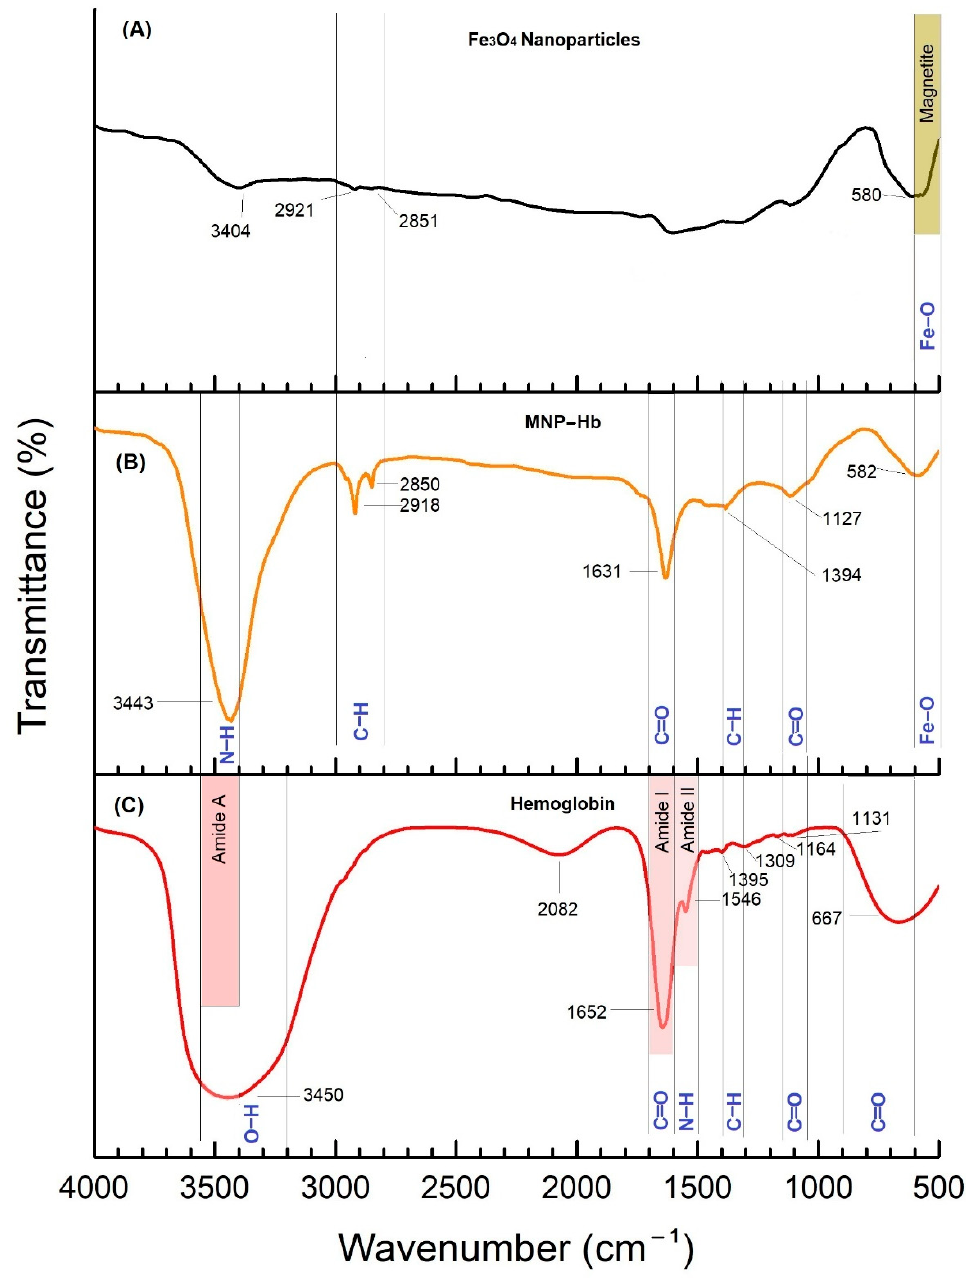
Figure 5. FTIR spectra of ( a ) bare magnetite nanoparticles, ( b ) hemoglobin and magnetite conjugates, ( c ) Hemoglobin. Note: MNP, MNP-Hb, and Hb represent magnetite nanoparticles, magnetite nanoparticles-hemoglobin conjugates, and hemoglobin, respectively.